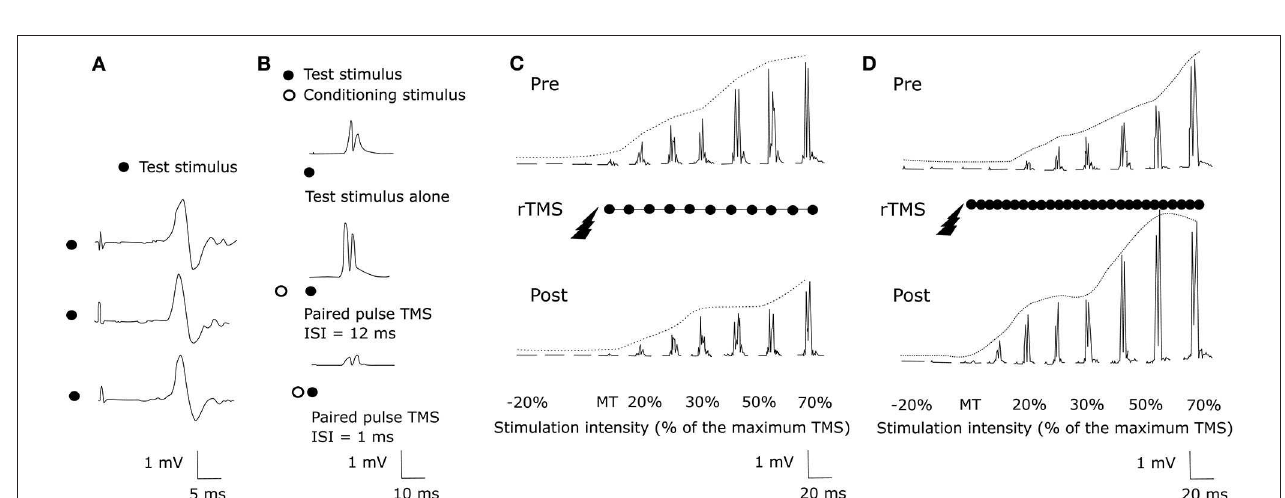
FIGURE 8 | Brain stimulation methods to reduce the seizure symptoms. (A) Transcranial magnetic stimulation (128) (B) Transcranial direct current stimulation (129) (C) Transcranial focused ultrasound stimulation (130).